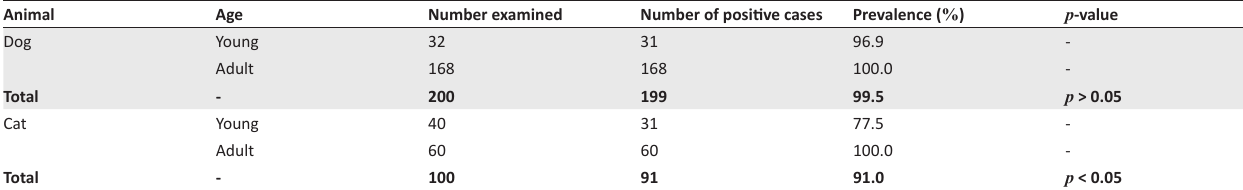
TABLE 4: Comparison of the overall prevalence of ectoparasites on young and adult study animals.